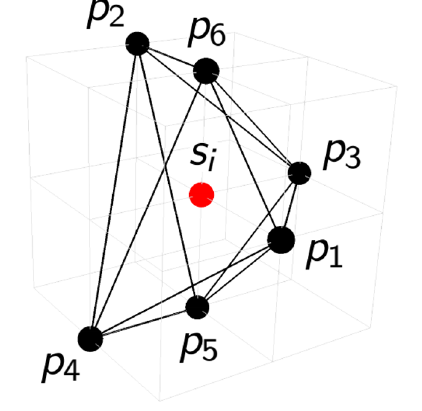
Figure 21 . Toric diagram for Model